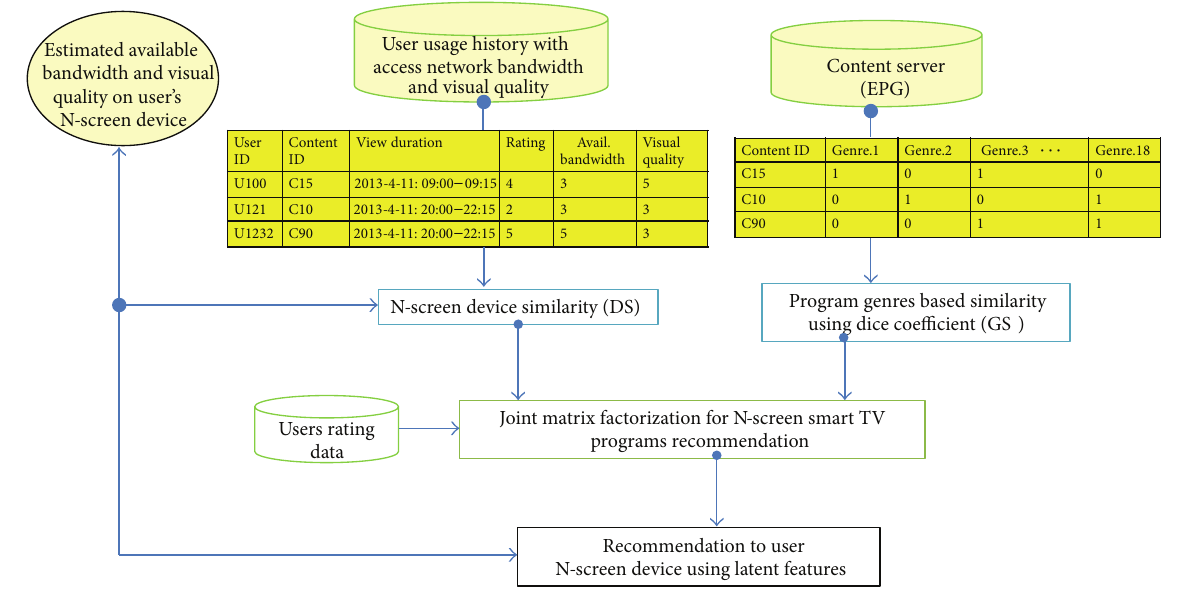
Figure 5: Algorithm for proposed network and visual quality aware N-Screen content